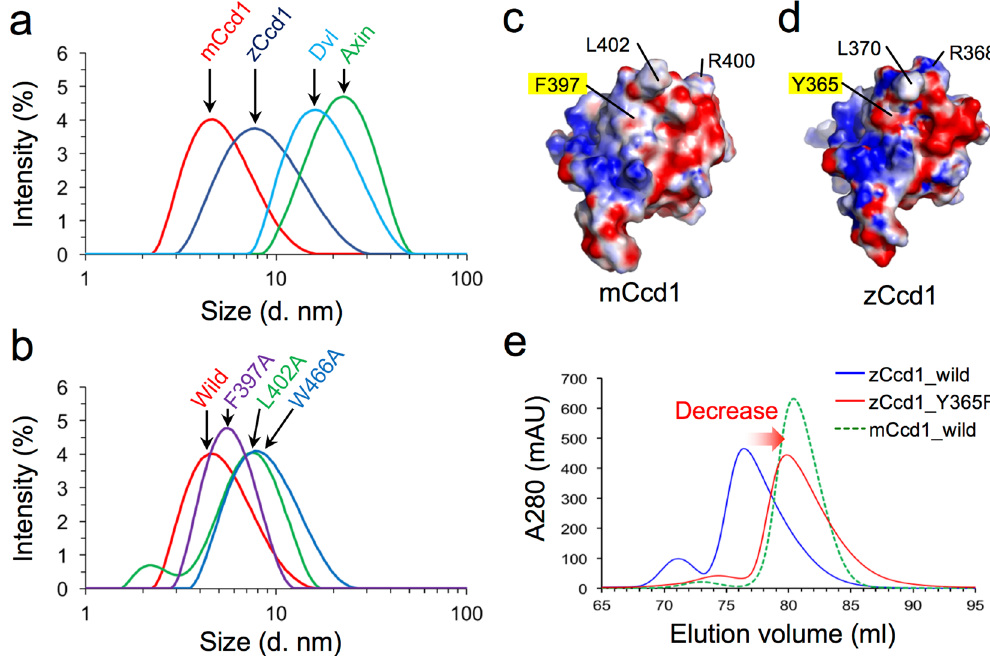
Figure 4. Residues responsible for mCcd1 auto-inhibition of homopolymerization. ( a ) Estimation of the apparent molecular size of mCcd1, zCcd1, Dvl1, and Axin DIX domains at the concentration of 100 μ M by dynamic light-scattering. ( b ) Comparison of mCcd1 mutants carrying indicated substitutions of amino acids located at the contact interface for the double-helical polymerization. ( c , d ) Surface electrostatic potential of molecular interfaces in double-helical polymerization of mCcd1 DIX ( c ) and single-helical polymerization of zCcd1 DIX ( d ) viewed from the same direction. Positive (blue) and negative (red) potentials are indicated. Two conserved residues, Leu and Arg, in loop β 1- β 2 and the side chains of Phe397 (mCcd1) and Tyr365 of (zCcd1) are indicated. ( e ) The effect of Y365F substitution on zCcd1 homopolymerization state. Gel filtration profiles of DIX domains of zCcd1 (wild-type and Y365F mutant) and mCcd1 (wild-type) are